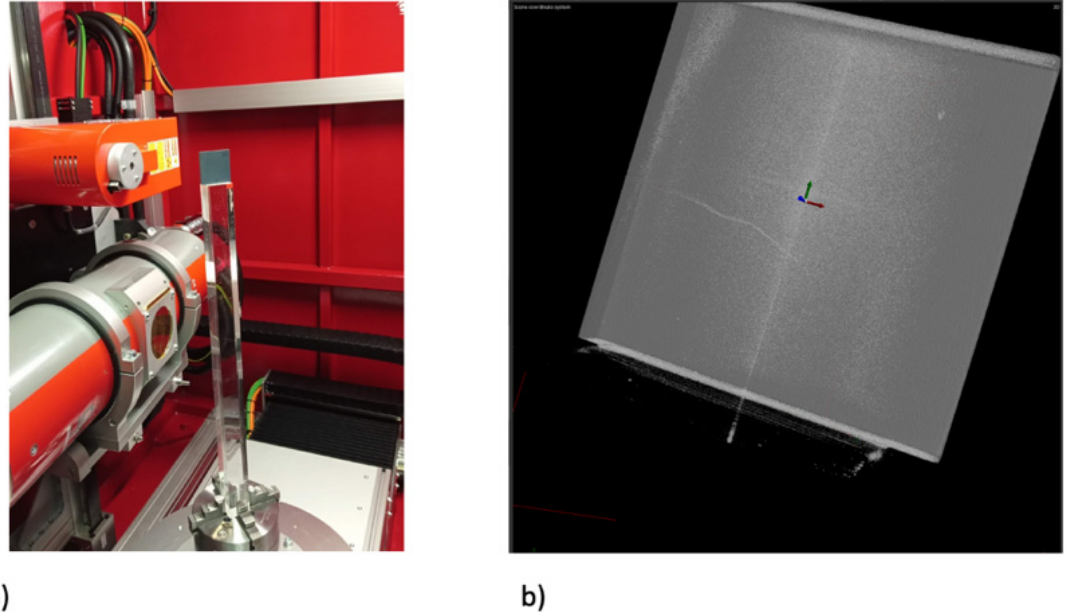
Figure 5. Industrial tomography (Gilardoni): ( a ) specimen (slab 23) within the tomography system; ( b ) 3D visualization within the full slab of crack, which propagates from the middle of the left edge towards the center. All images show the full 50 mm × 50 mm slab.